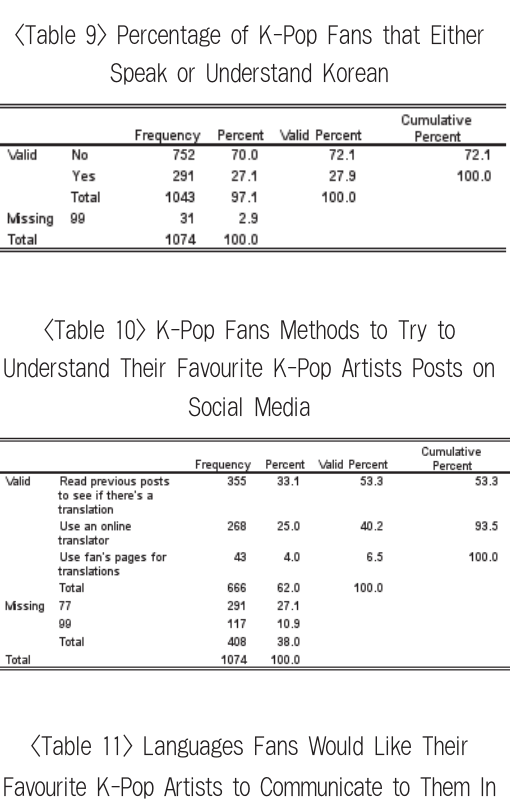
<Table 9> Percentage of K-Pop Fans that Either